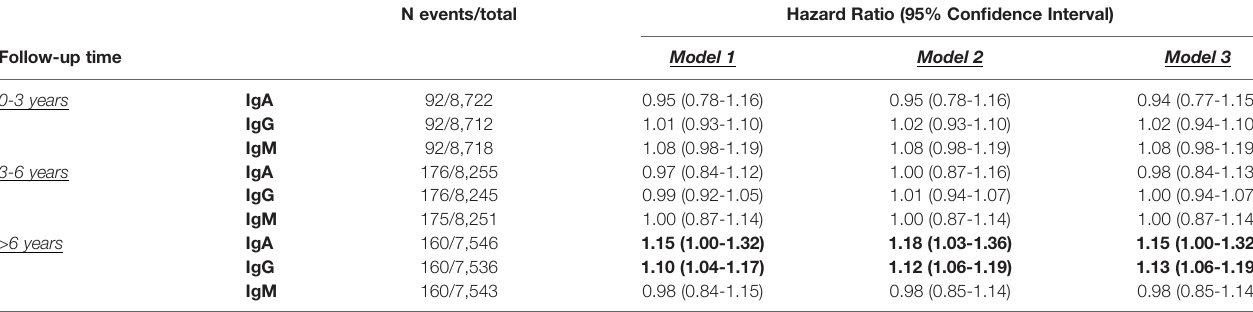
TABLE 4 | Association between serum immunoglobulins and risk of incident